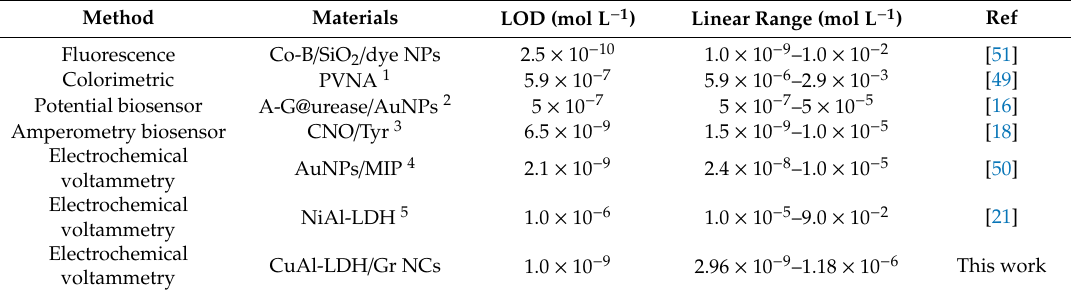
Table 2. Comparison of the sensor with other glyphosate detection works.